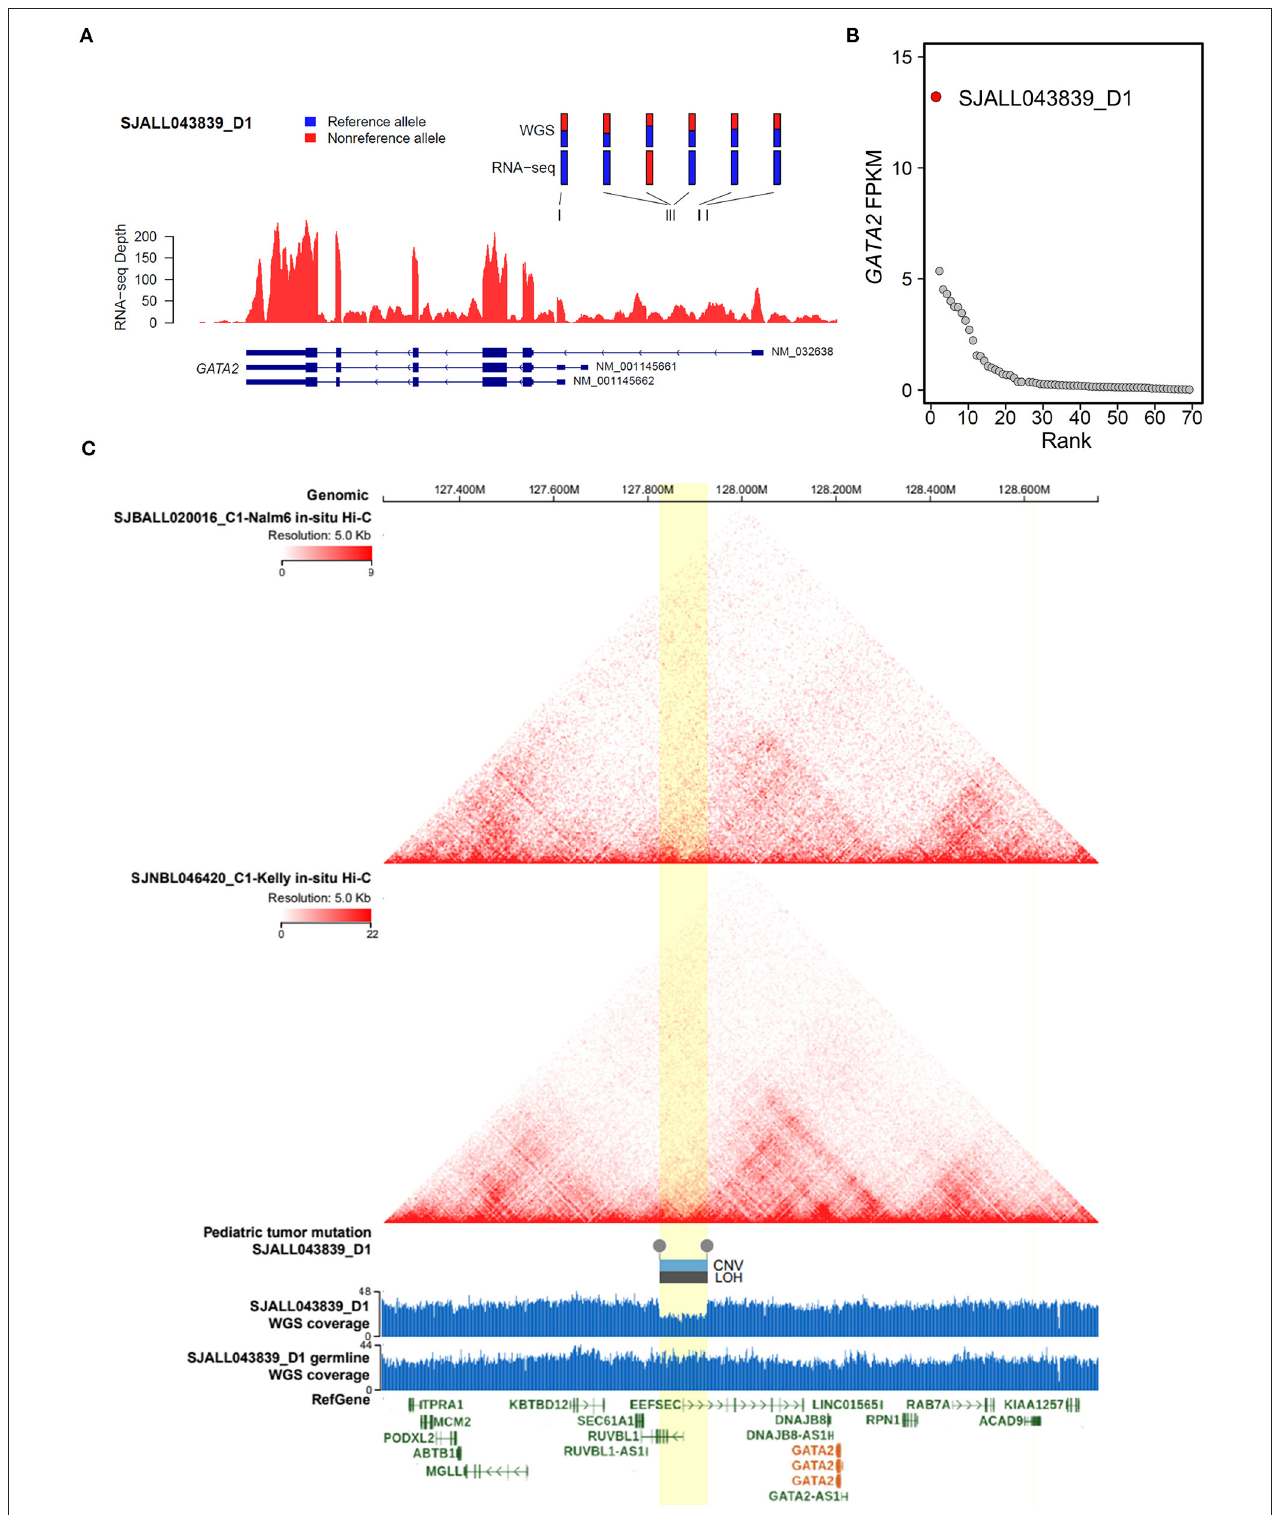
FIGURE 5 | Cis-activation of GATA2 due to a downstream focal deletion. (A) Allelic specific expression of GATA2 in SJALL043839_D1 was determined by examining the mono-allelic expression of six heterozygous germline/somatic variants, which are labeled above the wiggle plot, with blue and red representing the reference and alternative alleles, respectively. (B) Outlier high expression (FPKM on the y axis) of GATA2 was found in sample SJALL043839_D1 (red dot) from the Shanghai